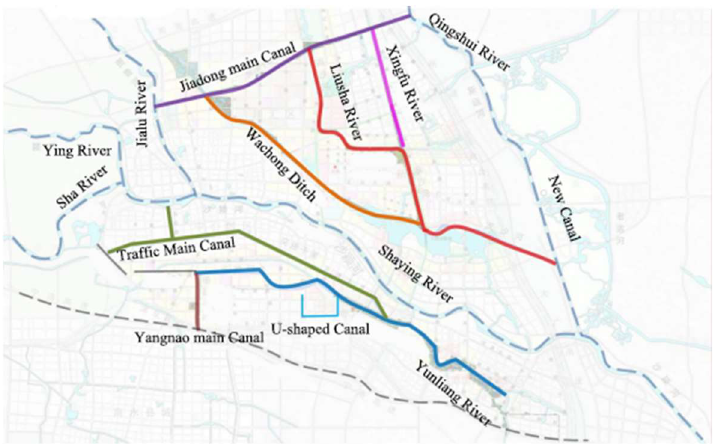
Figure 3. River system map of Zhoukou city center.